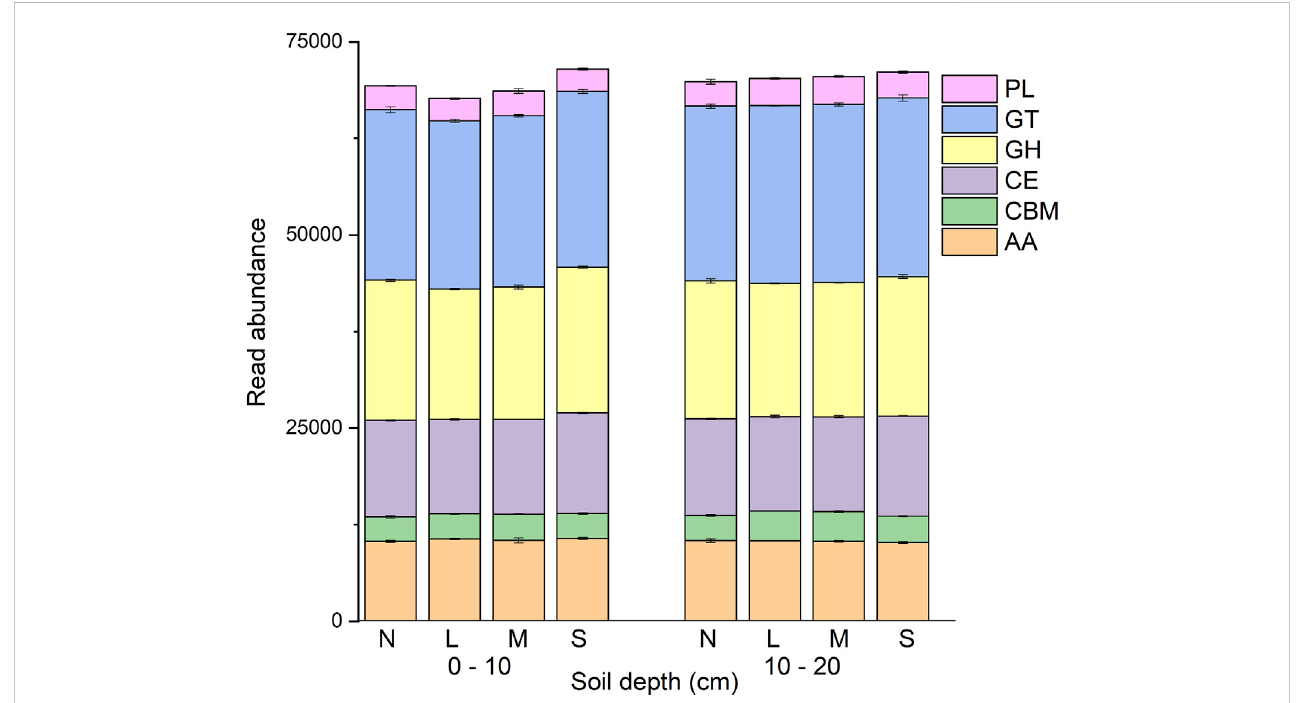
FIGURE 1 Read abundance of CAZyme families in grassland soil under various degradation severities and soil depth. N: non-degraded; L: lightly degraded; M: moderately degraded; S: severely